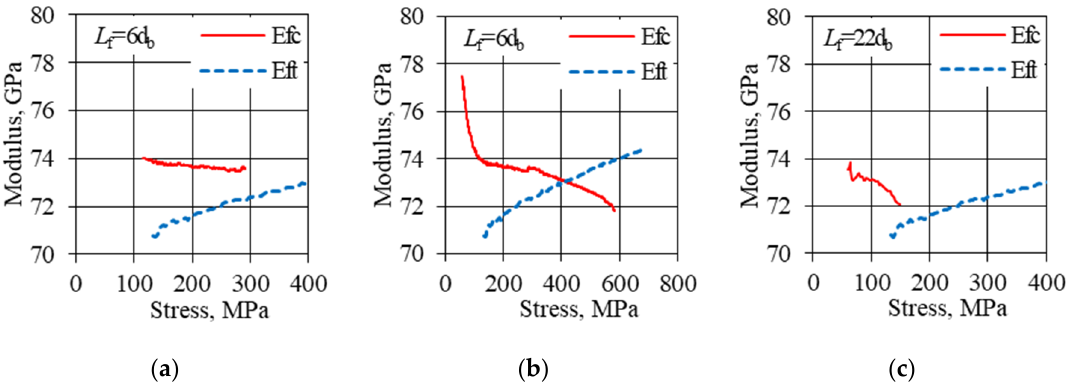
Figure 11. Comparison of the tangent modulus of elasticity at tensile E ft in the range of (0.1–1.0) f ut with the tangent modulus of elasticity in compression: ( a ) L f = 6 d b , E fc in the range of (0.2–0.5) f uc ; ( b ) L f = 6 d b , E fc in the range of (0.1–1.0) f uc ; ( c ) L f = 22 d b , E fc in the range of (0.2–0.5) f uc (absolute stress value).